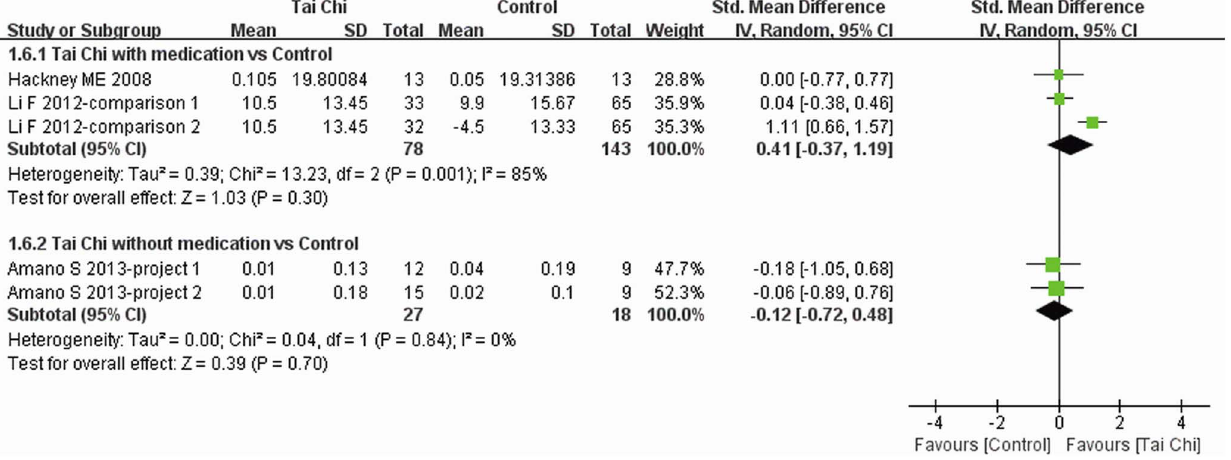
Figure 8. The effect of Tai Chi on gait velocity. Subgroup analysis was performed according to whether or not medications were included in the intervention. Standardized mean difference was used for different units of velocity.